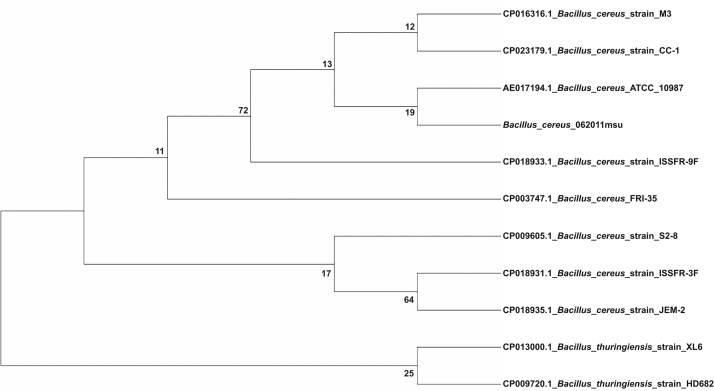
Phylogenetic tree obtained from 23S rRNA comparison of Bacillus cereus 062011msu with its closely related homologs using the MEGA7 software.